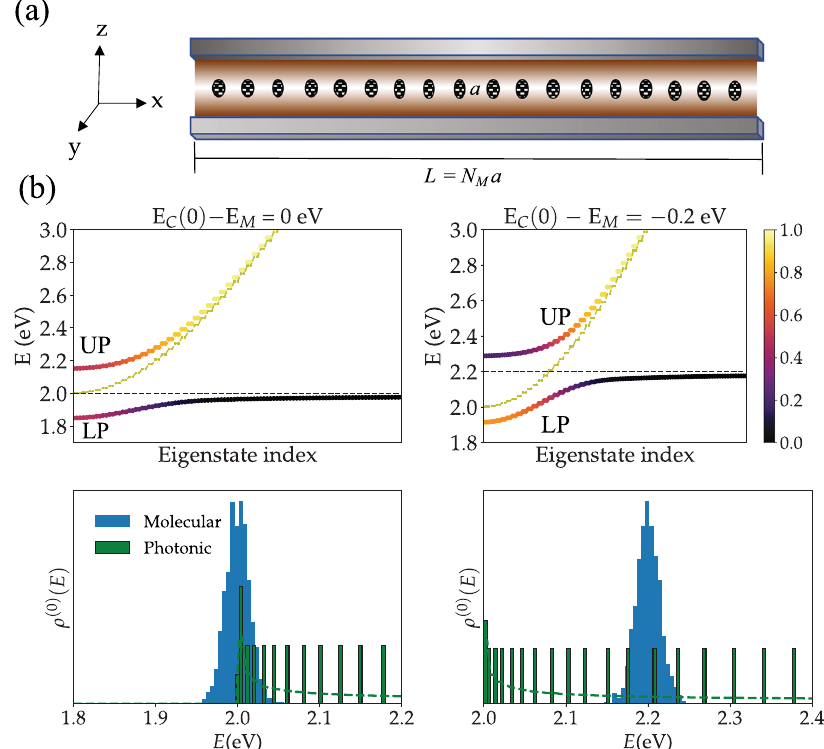
Fig. 1 Schematic representation of photonic wire model for multimode polariton chemistry. a Section of the photonic wire model employed in this work. Molecules (ovals) extend homogeneously (in average) along x with constant z and y . The distance between the N M molecules is in average a . b Subset of the energy spectrum (obtained from exact diagonalization of a single realization of the Hamiltonian of a system with 1001 molecules and cavity modes, Ω = 0.3eV, σ / Ω = 0.05, and other parameters as listed in “ Thermodynamic limit convergence ” ) of the empty cavity (dashed yellow), lower polariton R R (LP), and upper polariton modes (UP) are shown as a function of eigenstate index i = 1, 2,...,1001, with E 1 < E 2 <... for cavities with q = 0 (top left) and q > 0 (top right) modes on-resonance with the disordered molecular ensemble (mean excitation energy given by the horizontal dashed line). Only the fi rst 100 modes of the LP and UP are shown. Each point is colored according to the photonic content of the corresponding state, where darkest corresponds to zero and brightest to 100%. Thus, bright points correspond to visible peaks in transmission spectra. The LP band includes the weakly coupled molecular reservoir modes ( “ dark states ” ) as is clear from the color of the corresponding points. The bottom left and bottom right shows the (single realization) bare molecule DOS, and rescaled (for the sake of clarity, as the exact number is too small compared to the molecular) discretized photonic DOS for representative zero and red-detuned cavities (in the N C → ∞ limit, the DOS becomes continuous and a singularity arises at E C (0)). Note that in the zero- detuning case, the subset of molecules with the lowest energies is off-resonant with all cavity modes and therefore the effects of the con fi ned fi eld on such molecules is smaller. Dashed green curves in each of the bottom fi gures correspond to smooth interpolations of the cavity density of states from the computed discrete mode distributions presented as